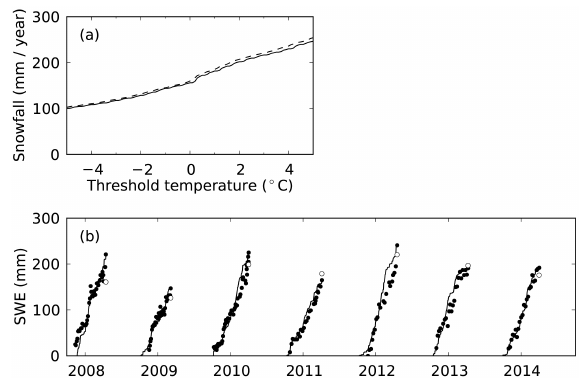
Figure 3. (a) Average annual snowfall derived from total precipita- tion with varying temperature (solid line) or wet-bulb temperature (dashed line) thresholds. (b) SWE on the ground from manual ob- servations up to the maximum each winter (black dots), cumulated snowfall up to the date of maximum SWE (white dots) and snowfall scaled to the annual maxima (black